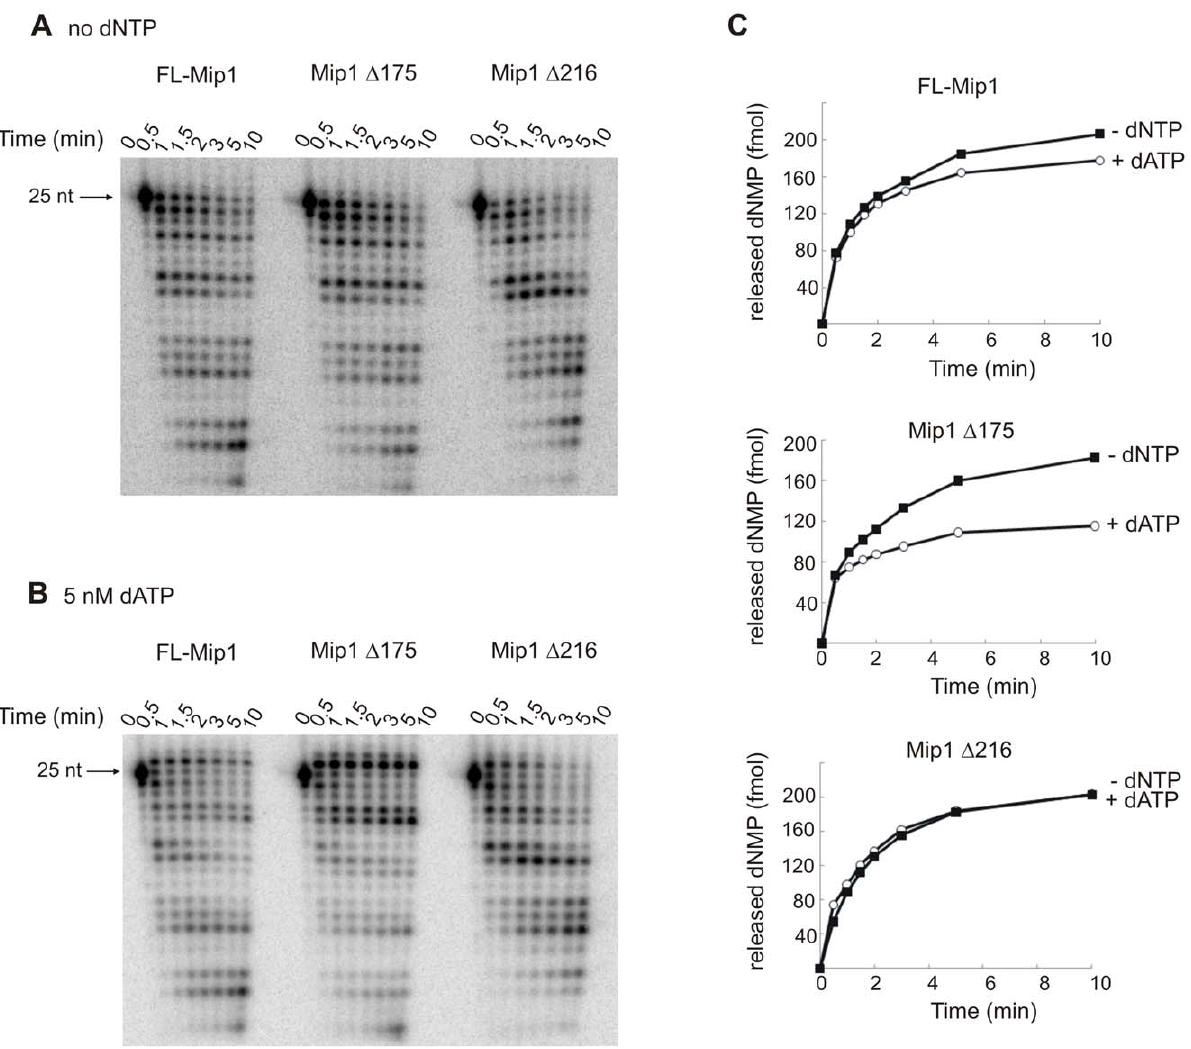
Figure 7. Exonuclease activity of Mip1 and C-terminal deletion mutants. Exonuclease activity was assayed on a 45 nt template primed with a radiolabeled 25 nt primer. 4 nM DNA polymerase was incubated with 2 nM 45/25 substrate in the total absence of dNTP or in the presence of 5 nM dATP. Reactions were carried out at 30 u C and stopped at indicated time points with equal volume of 80% formamide, 25 mM EDTA. A. Reaction products without dNTP were resolved on 8% urea polyacrylamide gel. B. Reaction products with 5 nM dATP were resolved on 8% urea polyacrylamide gel. Position of the 25 nt primer is indicated. C. Exonuclease activity was calculated as the amount of released dNMP from the reaction products. The proportional amount of the products was calculated from the intensity of the signal and the amount of the dNMP released during the reaction, taking into account the size of each of the exonuclease products. The amount of released dNMP was plotted against time. Filled square – reaction in the absence of the dNTP, empty circle – reaction in the presence of 5 nM